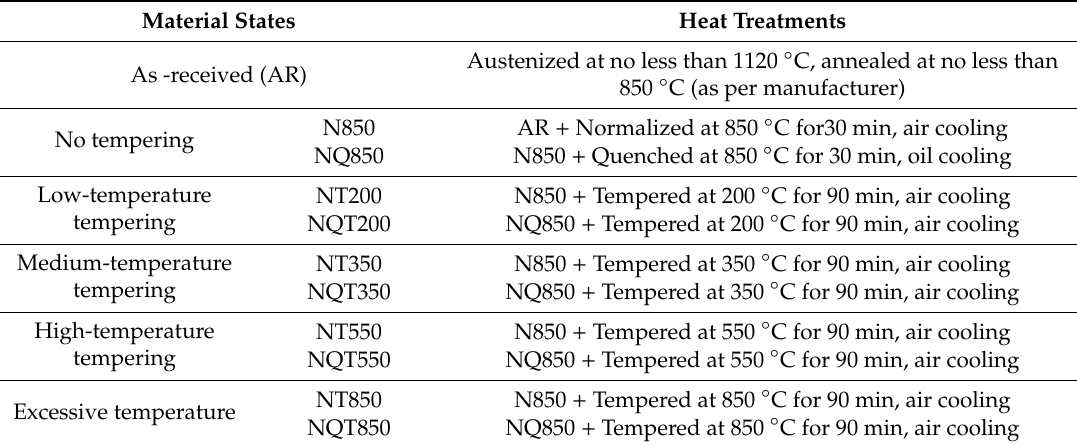
Table 2. Di ff erent material state of 25CrNi2MoVE steel investigated in present